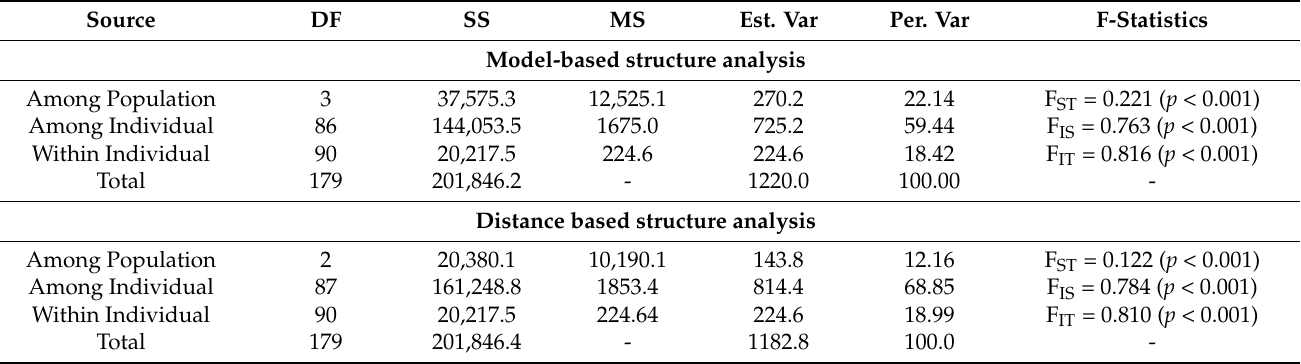
Table 3. Analysis of molecular variance (AMOVA) among 90-cowpea accessions classified based on SNP